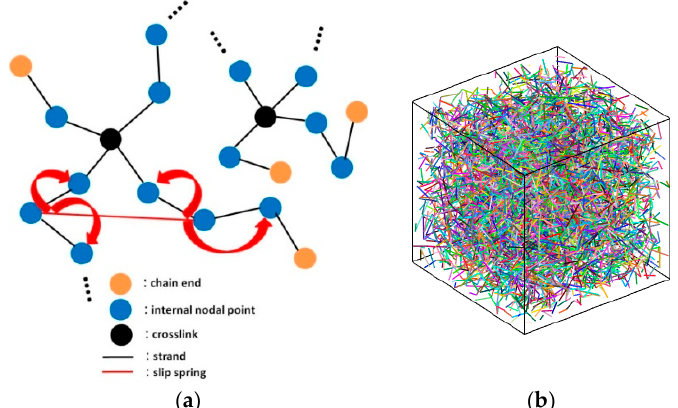
Figure 1. ( a ) Representation of a polymer network at the coarse-grained level. End beads, internal beads, and crosslink beads are shown as orange, blue, and black circles, respectively. A slip spring is shown as a red line. Red arrows indicate possible jumps that can be executed by the ends of the slip spring. ( b ) Visualization of the crosslinked cis -PI with all nodal points being folded back into the simulation box. The different colors of strands are chosen randomly.